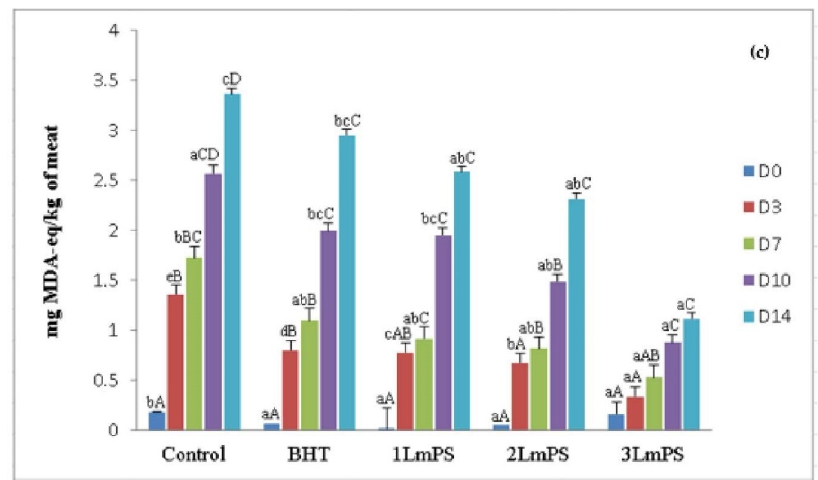
Figure 1. Lm PS incorporation effect on ( a ) pH, ( b ) metmyoglobin (%), and ( c ) thiobarbituric-acid reactive substances (TBARS) (mg malondialdehyde/kg) in crude minced meet within a shelf life of 14 days of storage at 4 °C. Mean ± standard deviation ( n = 3). Letters a–d: values of the same storage day are significantly different ( p < 0.05); letters A–D: values of the same concentration are significantly different.